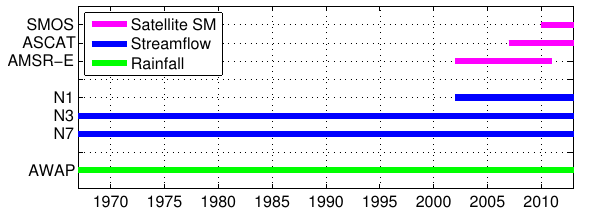
Figure 2. Periods of record of the different data sets. The initial date of the plot was set as the beginning of the streamflow data